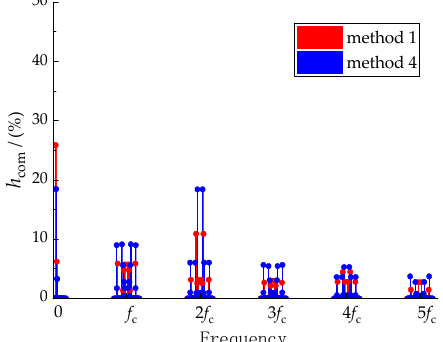
Figure 10. Spectrum of the common-mode components at m = 0.3.